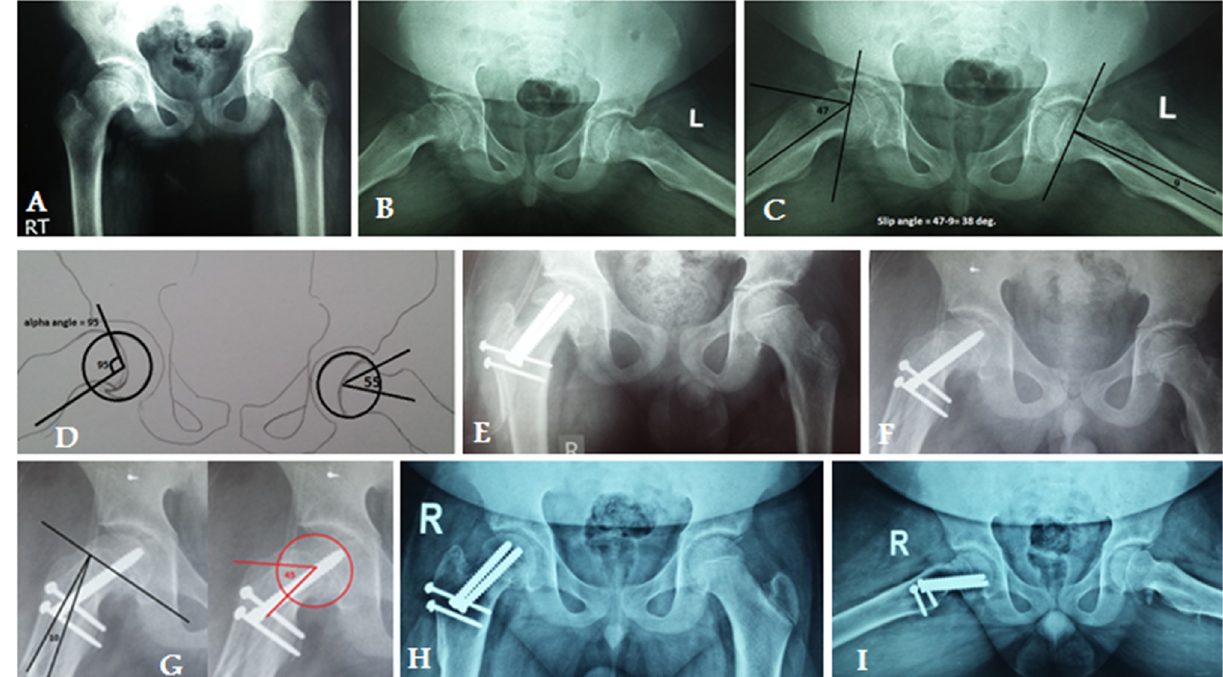
Figure 5. X-ray in 15-year-old male with Rt chronic stable SCFE (case number 4): (A) preoperative AP pelvis, (B) preoperative frog lateral view of both hips, (C) preoperative measurement of Southwick slip angle, (D) preoperative measurement of the alpha angle, (E) and (F) postoperative AP and frog view, (G) postoperative measurement of Southwick slip and alpha angles, (H) 12-month postoperative AP and frog lateral X-ray showing complete union of trochanteric osteotomy and physis with no evidence of